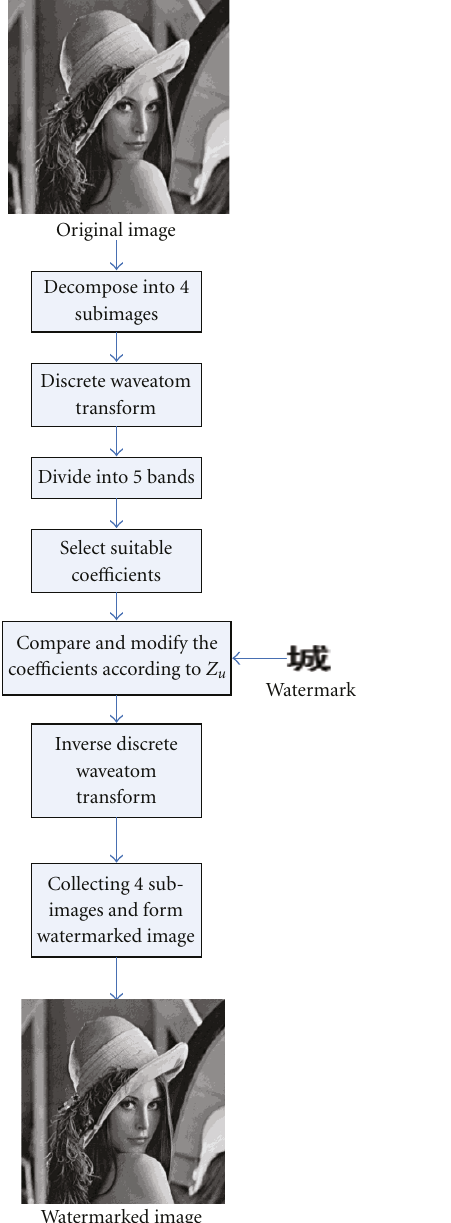
Figure 1: The embedding